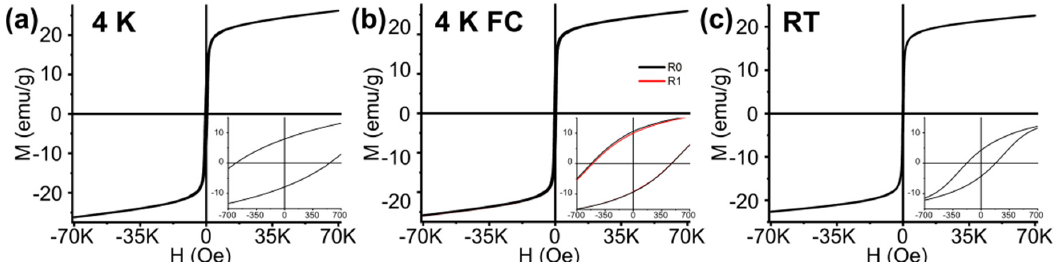
Figure 5. Hysteresis loops of sample S3 with maximum applied field equal to 70 kOe. The insets show the low field regions of each loop. ( a ) Hysteresis recorded at 4 K; ( b ) Hysteresis recorded at 4 K after cooling under an applied field equal to 70 kOe. R0 indicates the hysteresis recorded after cooling, R1 refers to the hysteresis recorded immediately after the first one; ( c ) Hysteresis recorded at RT.